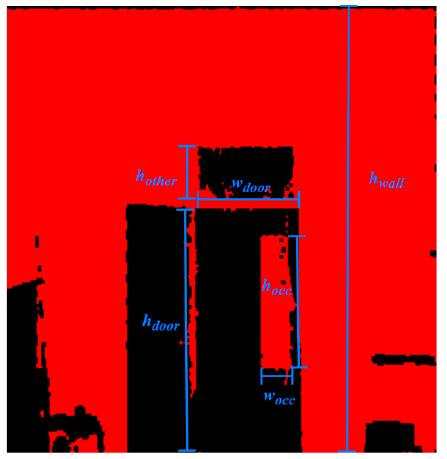
Table 1. Summary of parameters for model extraction and reconstruction.